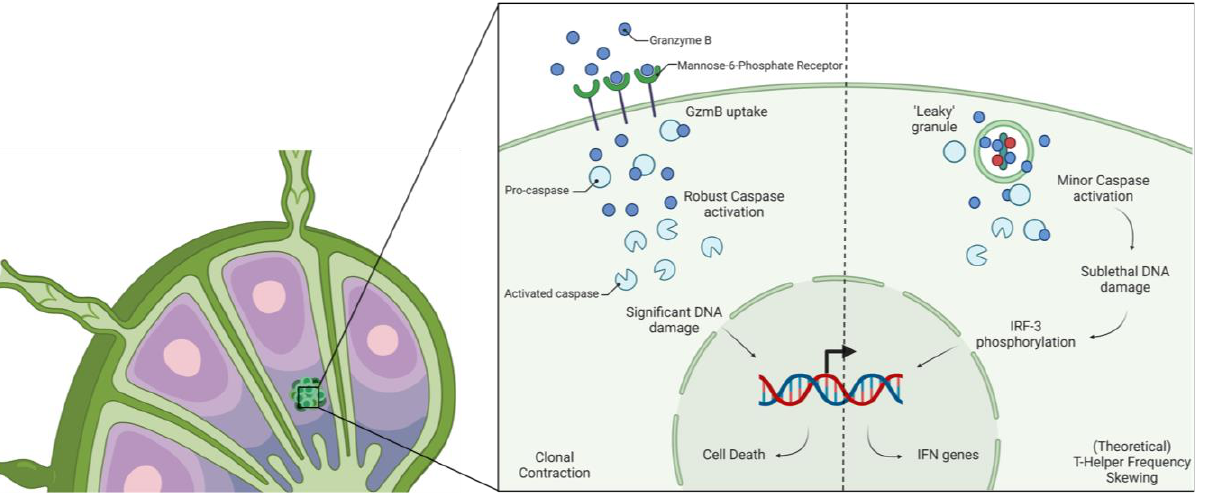
Figure 2. Schematic representation of the novel roles of GzmB in T cell development. ( Left ) Mannose-6 Phosphate receptor expression orchestrates the amount of GzmB introduced into the cell, allowing for robust activation of caspase and clonal contraction. ( Right ) Theoretical mechanism of leaky granule release resulting in the production of IFN genes through minor DNA damage, skewing T helper frequency. IRF-3 = Interferon Regulatory Factor 3; GzmB = Granzyme B; IFN = Interferon.